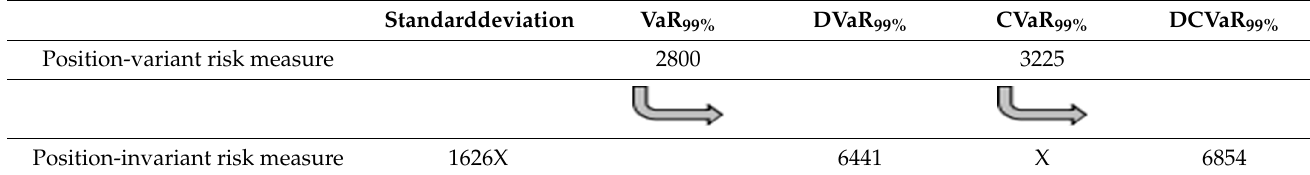
Table 6. Calculation and conversion of position-variant risk measures into position-invariant risk